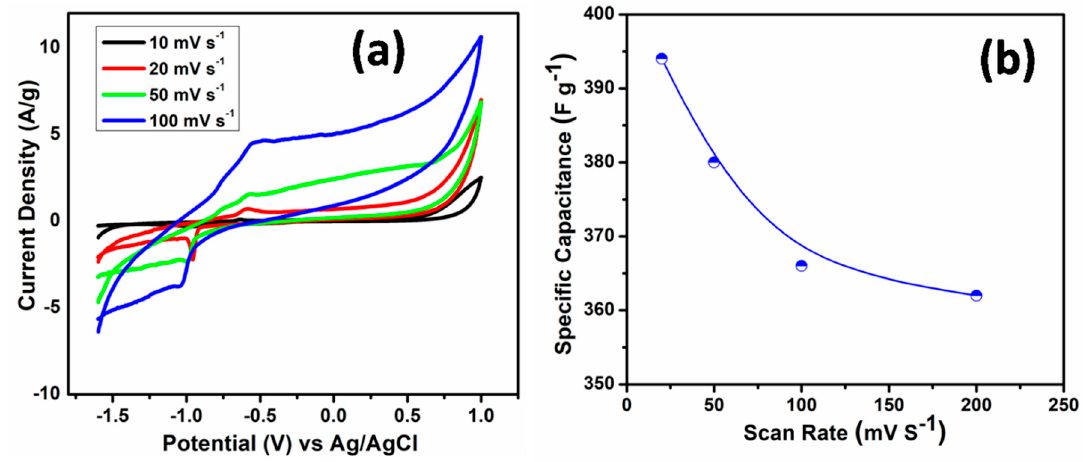
Figure 6. ( a ) CVs of ZnO nanorods electrode at various scan rates with 2M KOH electrolyte and Ag / AgCl as reference electrode. ( b ) Variation of specific capacitance of ZnO nanorods electrode with different scan rate.